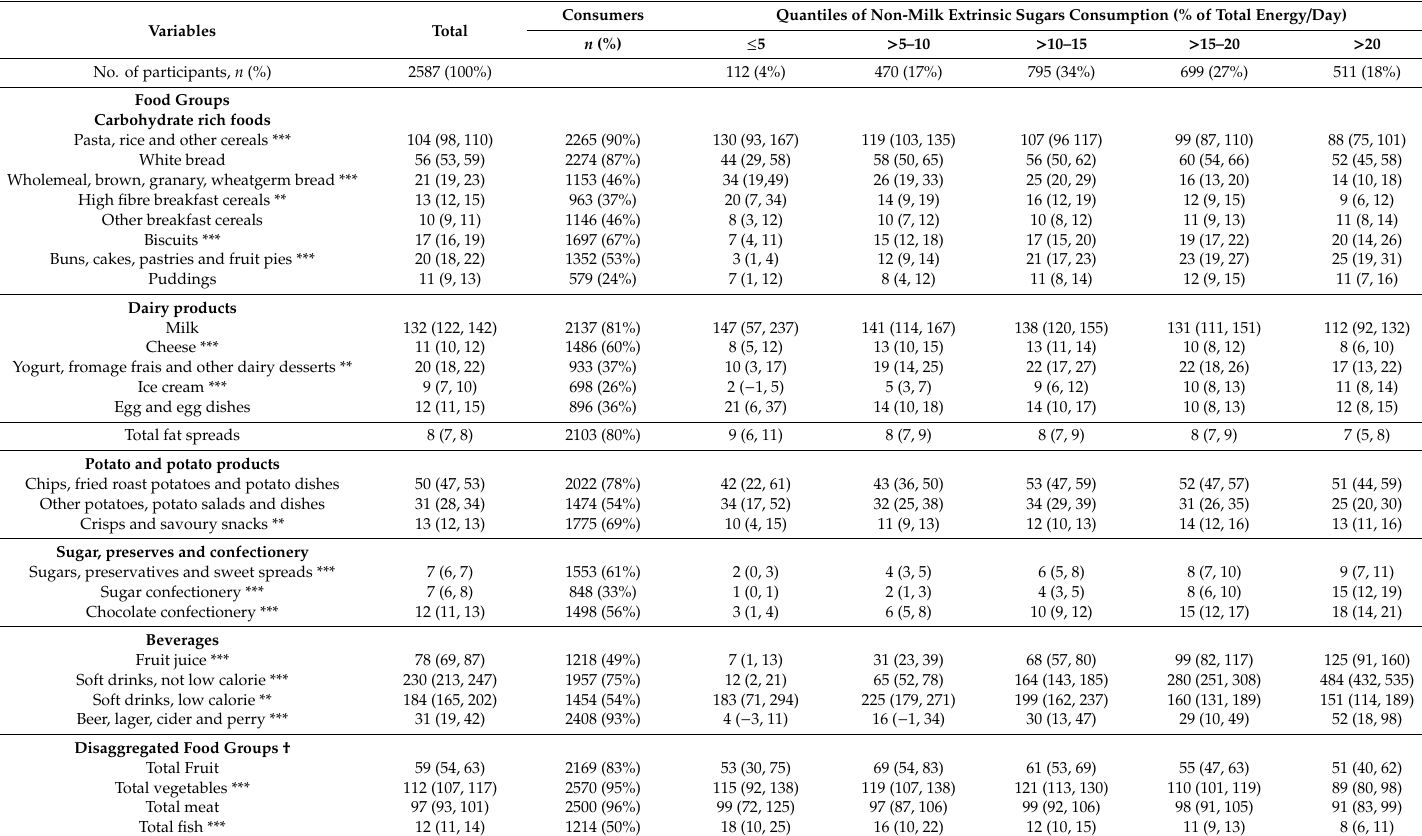
Table 2. Food group intakes (g / day) of adolescents aged 11 to 18 years in the National Diet and Nutrition Survey Y1-8 by category of non-milk extrinsic sugar (NMES) consumption as a percentage of total energy after the application of Y1-8 survey weights, expressed as mean (99% CI). Consumers Variables Total